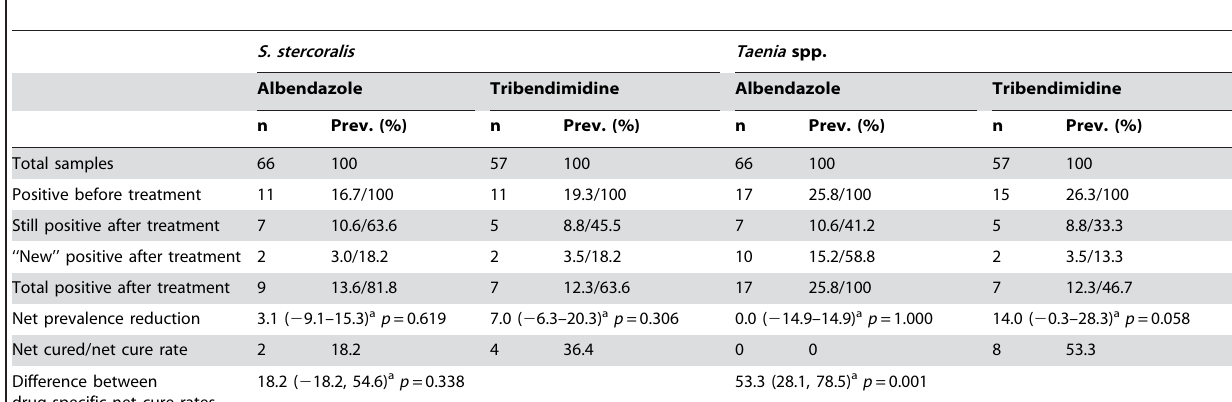
Table 3. Prevalence and net cure rates of S. stercoralis and Taenia spp. taking into account ‘‘new’’ infections discovered at follow- up among previously ‘‘negative’’